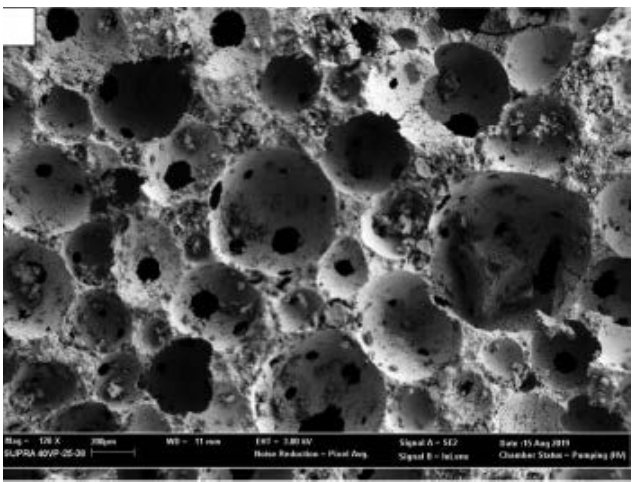
Figure 15. Examples of geopolymer compounds with improved thermal functionality: FGC microstructure (reproduced with permission from Pasupathy et al., Construction and Building Materials; Elsevier, 2020).